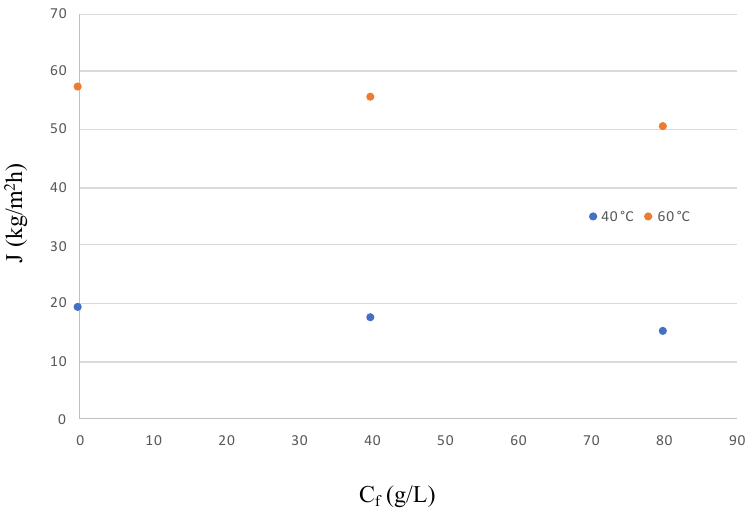
Figure 11. DCMD tests. The trend of the flux with time. Feed: 80 g/L; 80 °C.